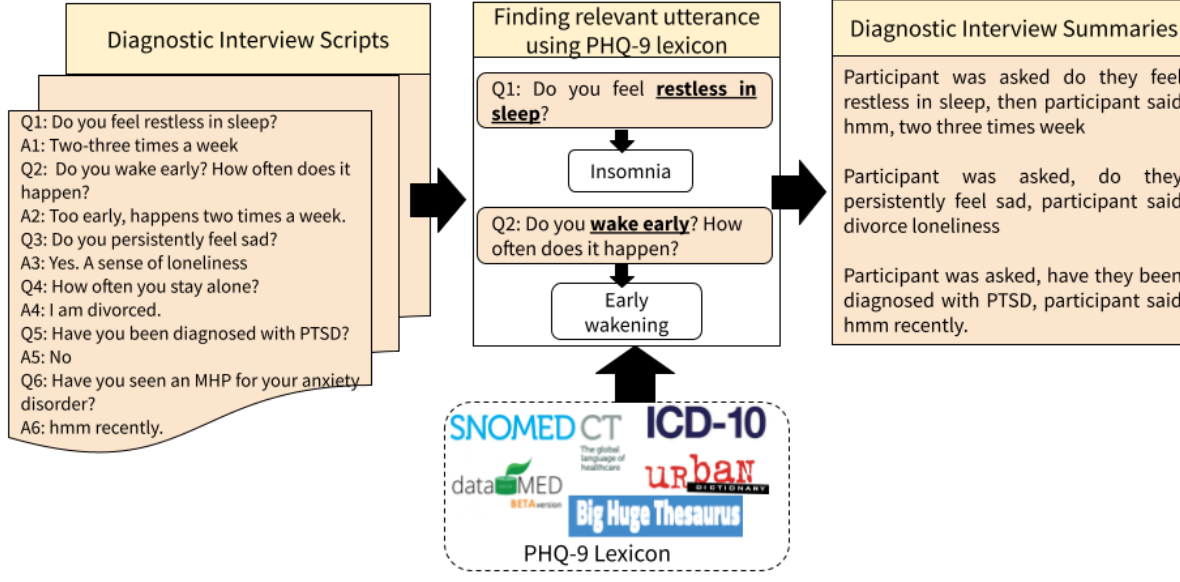
Figure 1. Overview of knowledge-infused abstractive summarization for an interview snippet of a patient's responses to the question asked by Ellie (virtual interviewer). Phrases relevant to mental health are identified using the PHQ-9 lexicon. The contextual similarity between utterances is calculated through a retrofitted embedding model. The resulting summaries contain relevant questions and meaningful responses. ICD-10: International Statistical Classification of Diseases, Tenth Revision; MHP: mental health professional; PHQ-9: Patient Health Questionnaire-9; PTSD: posttraumatic stress disorder; SNOMED CT: SNOMED Clinical